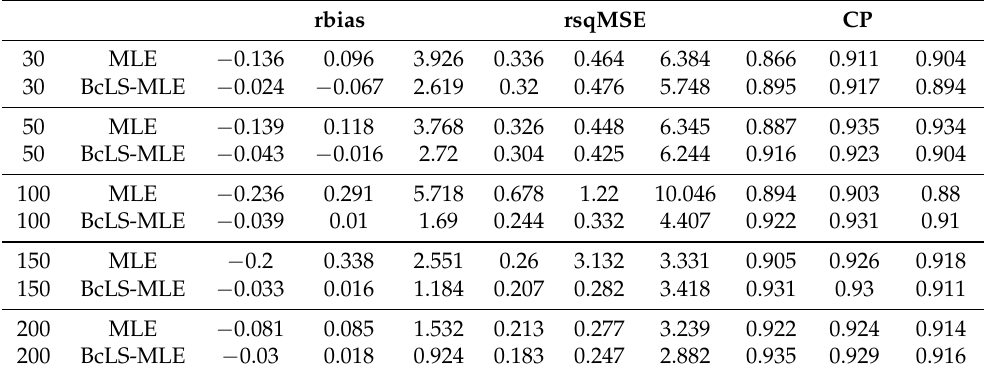
Table 9. The rbias and rsqMSEs of the BcLS-MLE and MLE, and the CP of S ( y 0 | Θ ) for LPN ( Θ ) with ξ = 5, σ = 1, γ = 3, and 1 − α = 0.95.